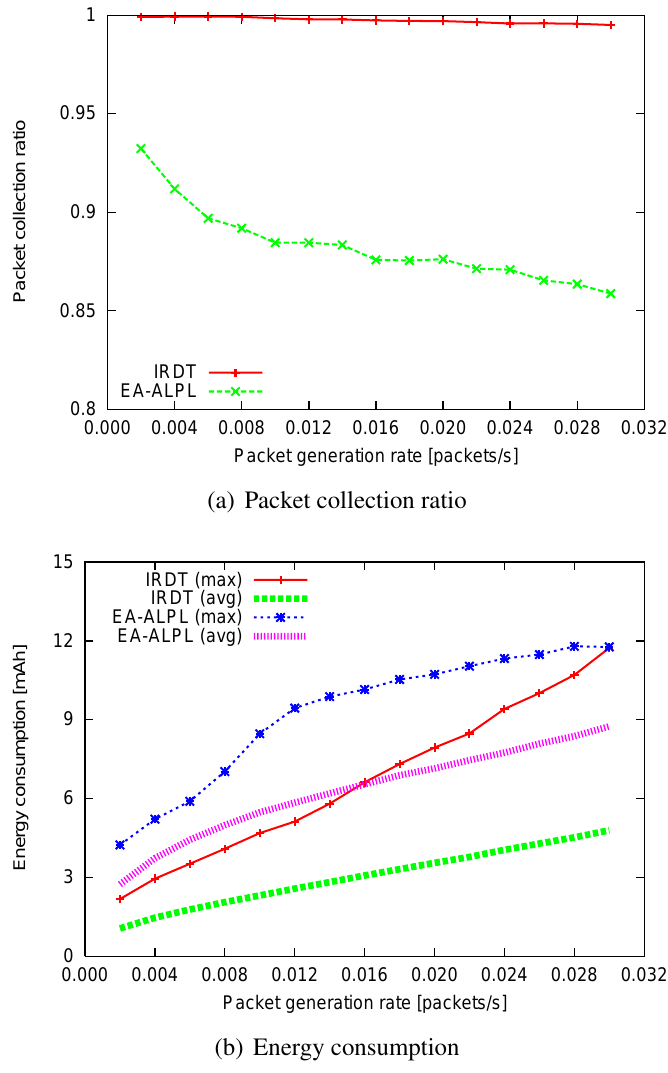
Figure 16. Performance using data aggregation and T ∗